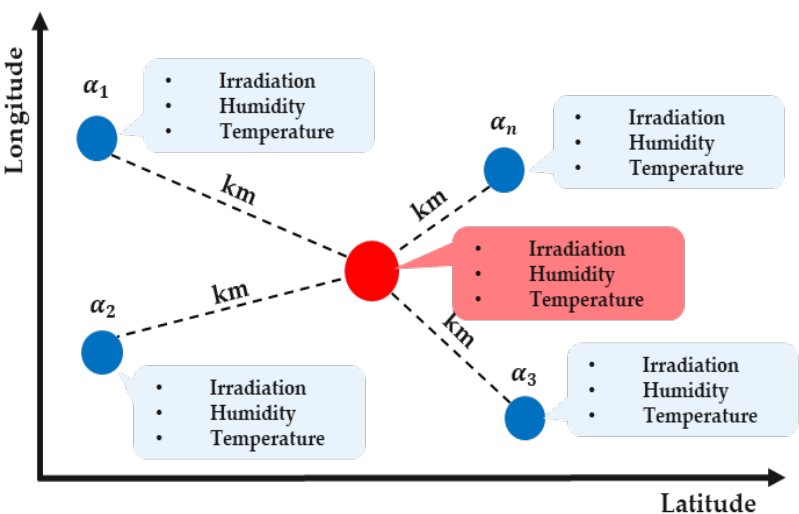
Figure 2. Visualization of the kriging technique.